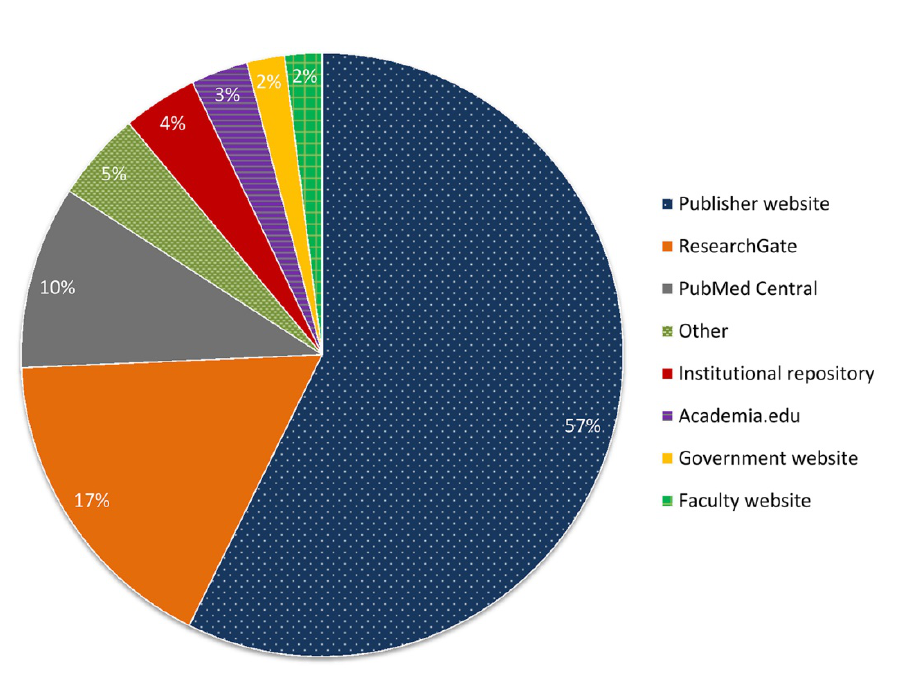
Figure 2 Sources of freely available